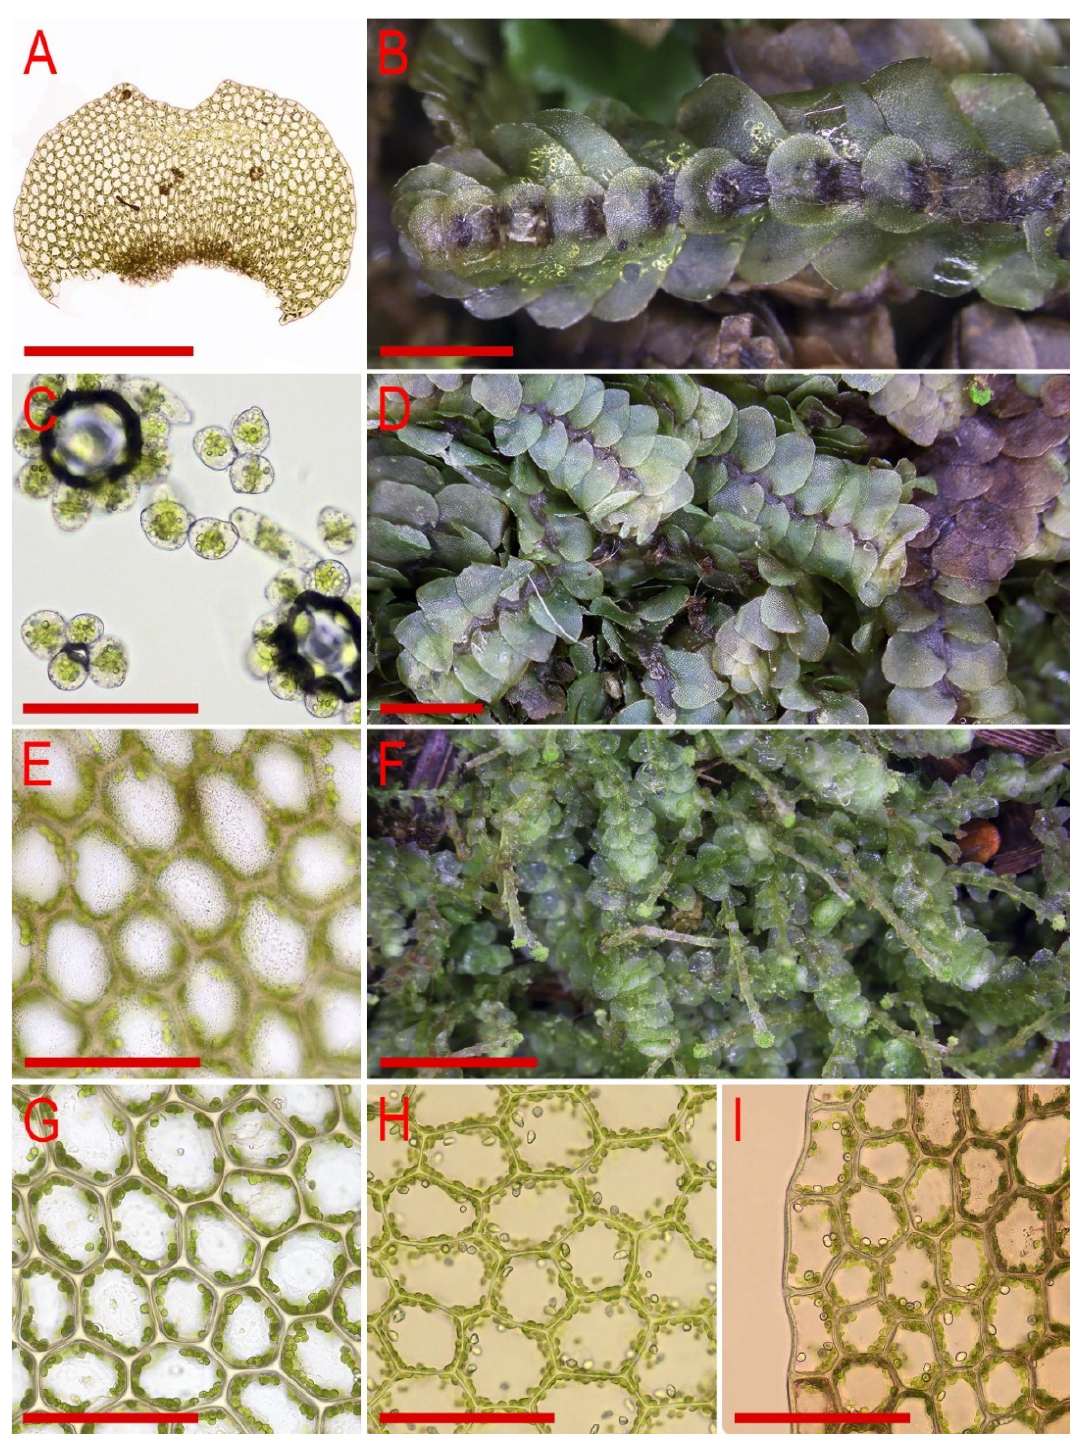
Figure 25. Calypogeia pseudointegristipula Bakalin, Troizk. et Maltseva, sp. nov. : ( A ) Underleaf; ( B ) Plant habit, fragment, ventral view; ( C ) Gemma with oil bodies; ( D , F ) Mats; ( E ) Verruculose cuticle; ( G , H ) Midleaf cells with oil bodies; ( I ) Leaf margin cells with oil bodies. Scales: 500 μ m for ( A ); 2 mm for ( B , D ); 5 mm for ( F ); 100 μ m for ( C , E , G – I ). ( A , B , D , E , G , I ) From K-34-34-18; ( C , F , H ) From S-43-3-16. All from VBGI.